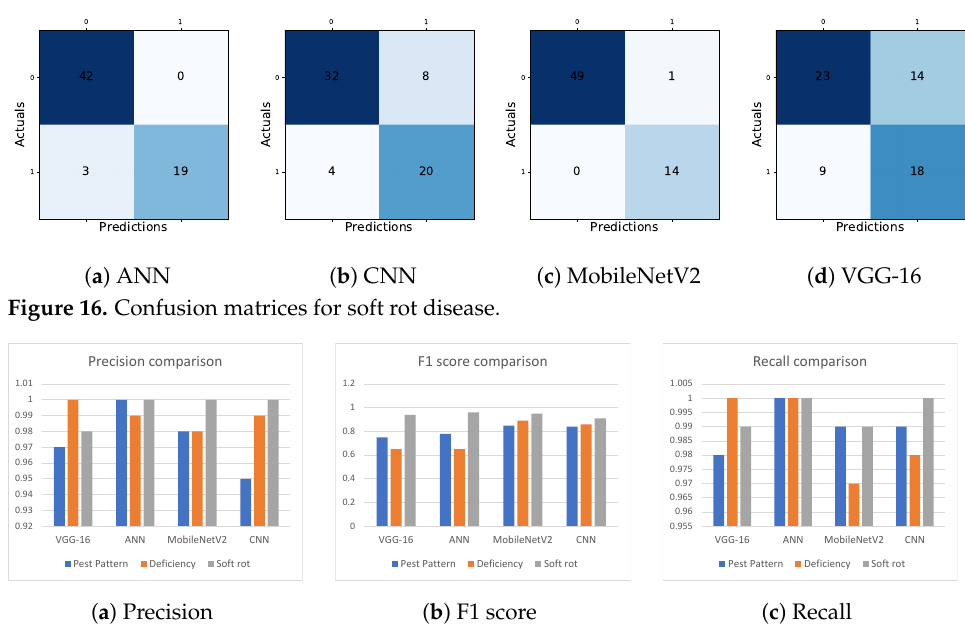
Figure 17. Comparison of Precision, F1 score and Recall values achieved on Pest Pattern, Deficiency and Soft rot classification by using ANN, CNN, MobileNetV2, and VGG-16 models.